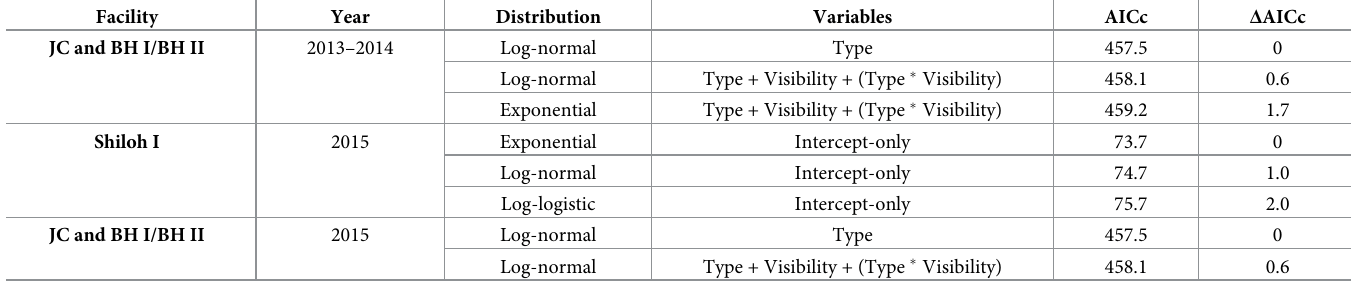
Table 9. Carcass persistence models a with corrected Akaike’s information criterion (AICc) and delta ( Δ ) AICc by facility and year for the Juniper Canyon (JC), Big Horn I (BH I), Big Horn II (BH II), and Shiloh I wind energy facilities. Facility JC and BH I/BH